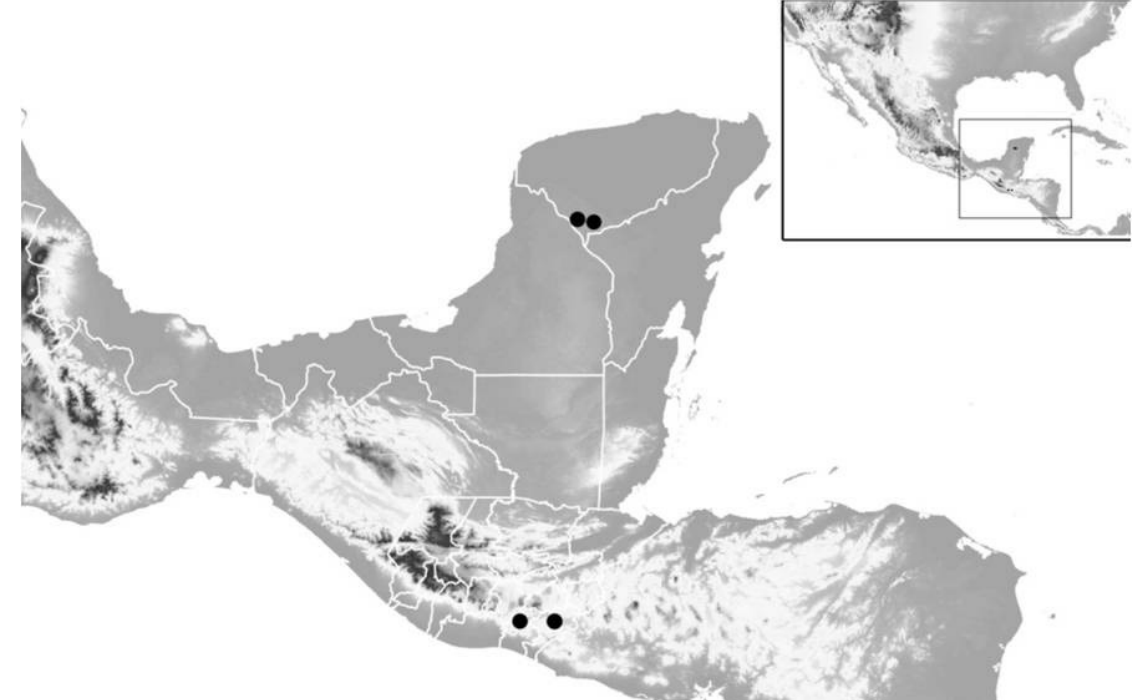
Fig 1 . Study area and sampling localities of Melipona yucatanica in Mesoamerican